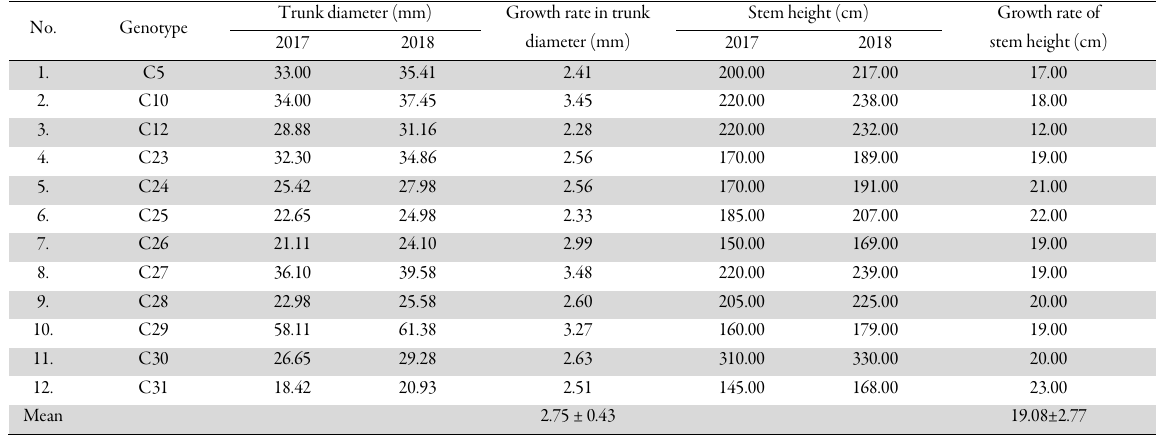
Table 1. Growth vigor of genotypes in Calopar population, expressed in terms of growth rate in thickness and height No. Genotype